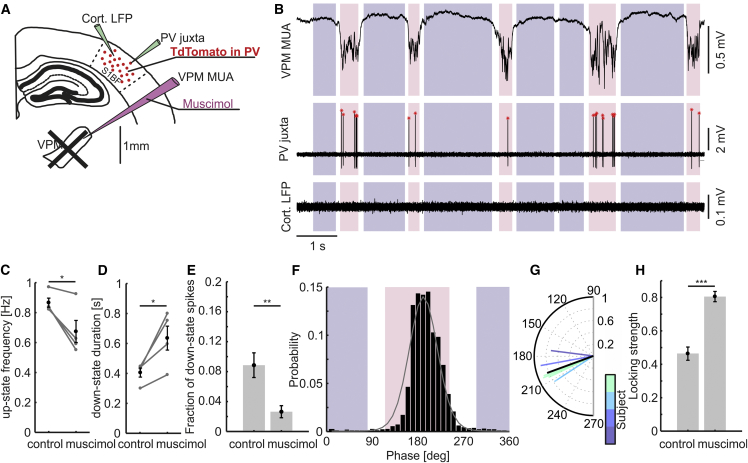
Thalamic Inactivation Significantly Reduces PV Spiking during Cortical Down States(A) Schematic of the experimental configuration. Muscimol is injected in the thalamus while measuring cortical LFP, thalamic MUA, and one cortical PV interneuron.(B) Representative traces of cortical LFP (top), juxtasomal recording from a PV interneuron (middle), and thalamic MUA (bottom) during up and down states after muscimol injection in the thalamus.(C and D) Up-state frequency (C) and average down-state duration (D) under control conditions and after muscimol injection in the thalamus (paired Student’s t test p = 0.0387 for C and p = 0.0367 for D; n = 4 animals).(E) Fraction of PV spikes recorded during down states under control conditions and after muscimol injection in the thalamus (p = 6.24E−3, Student’s t test; control, n = 8 cells; muscimol, n = 7 cells from 4 animals).(F) Phase of firing distribution of one representative PV interneuron after muscimol injection in the thalamus. Pink and purple indicate the global range of up- and down-state phases after muscimol application, respectively. The gray line reports the corresponding von Mises fit (μ = 191° and κ = 4.30).(G) Circular plot of the mean phase of firing of PV interneurons after muscimol application in the thalamus (n = 7 cells from 4 animals).(H) Locking strength under control conditions and after muscimol injection (p = 1.25E−5, Student’s t test; control, n = 8; muscimol, n = 7 from 4 animals).See also Figure S3.